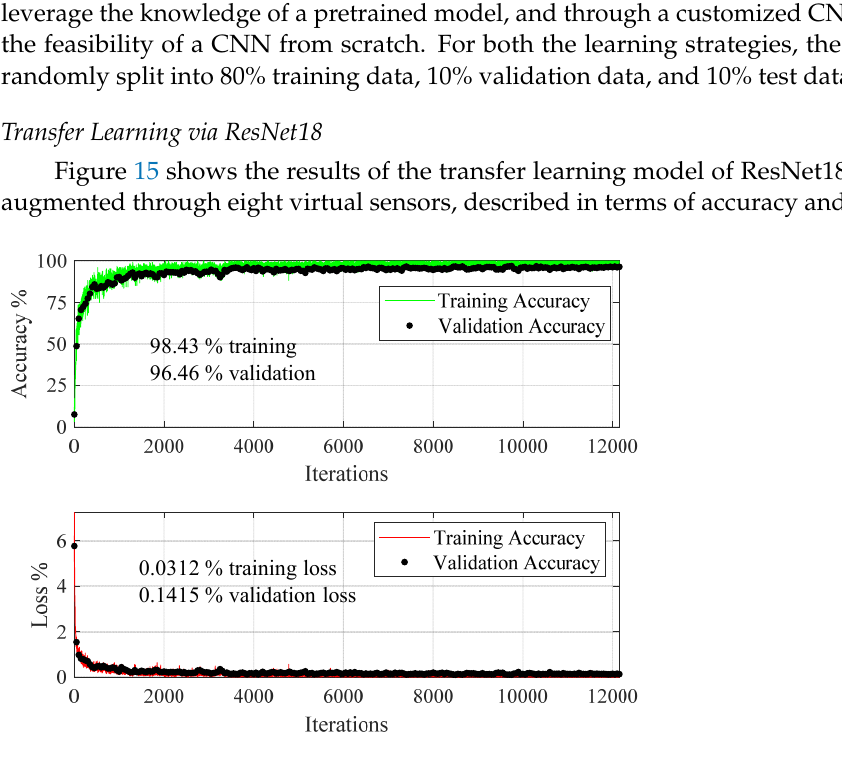
Figure 15. Training and validation results ResNet18 on data augmented data via eight virtual sensors. (Solid line shows training, dot refers to validation).